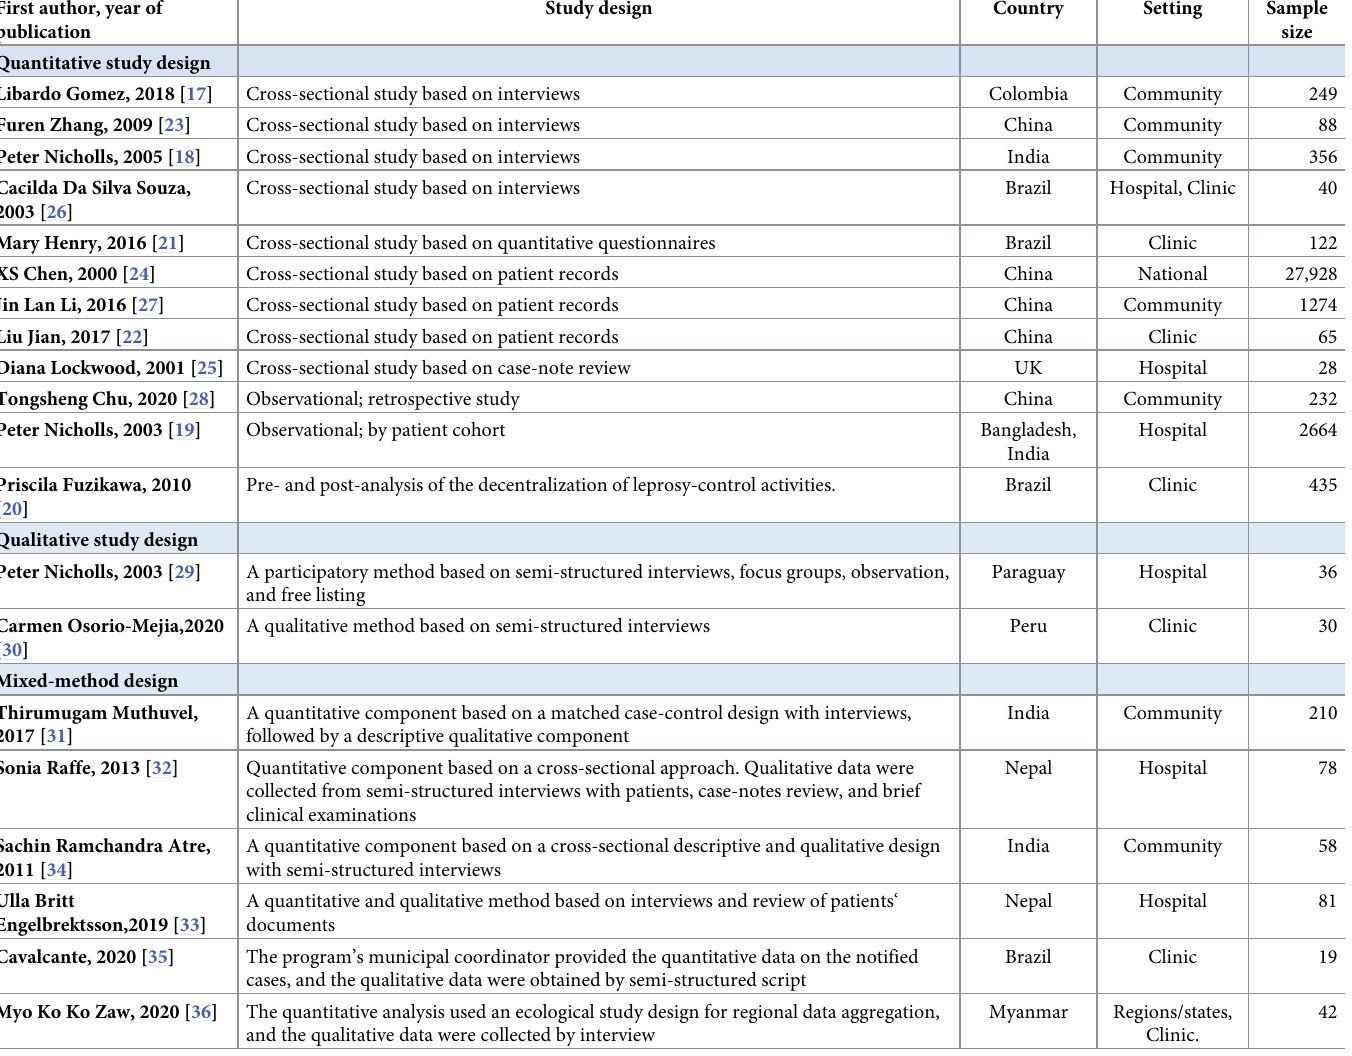
Table 1. Study characteristics of the included